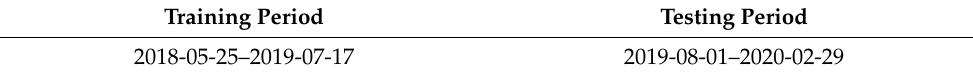
Table 17. Training and testing periods for Behaviour Predictor application.